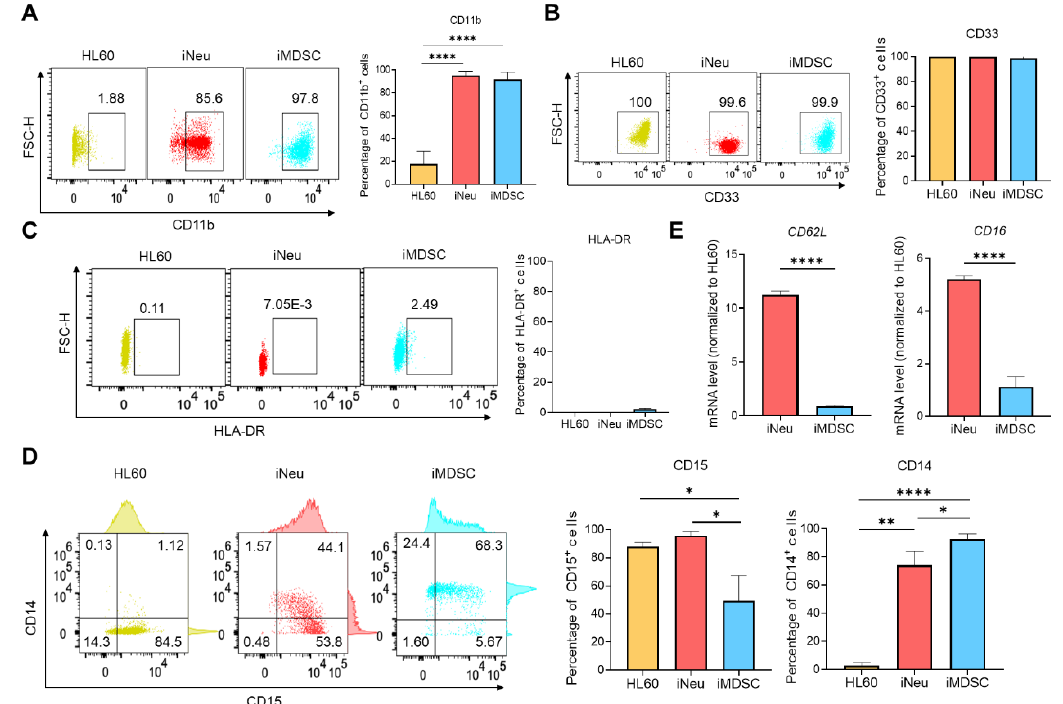
Figure 2. MDSC surface maker analysis for HL60, iNeu and iMDSC. ( A – D ) Flow cytometry analysis of CD11b, CD33, HLA-DR, CD14 and CD15 expression in HL60, iNeu and iMDSC. Both representative plots and average frequencies were shown. ( E ) Expression of CD62L and CD16 at the mRNA level in HL60, iNeu and iMDSC, measured by qRT-PCR. Relative mRNA was normalized to GAPDH (internal control) and HL60 (the reference baseline of 1.0). * p < 0.05, ** p < 0.01, **** p < 0.0001, two-tailed Student’s t-test. For ( A ) and ( D ), one-way ANOVA followed by multiple comparisons returned equivalent significance levels.